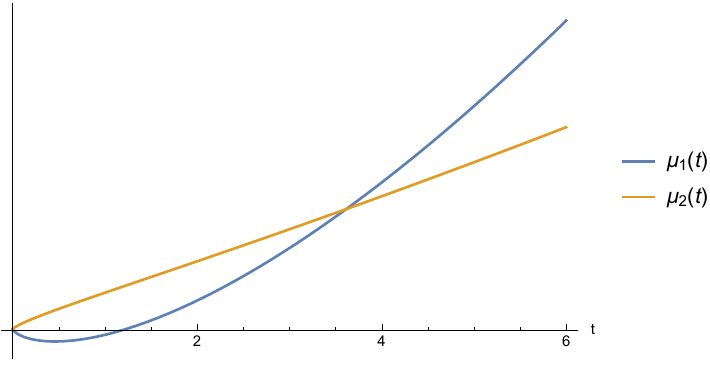
Fig. 12 The solutions of the initial value problem 40–41 for α = 0 . 7